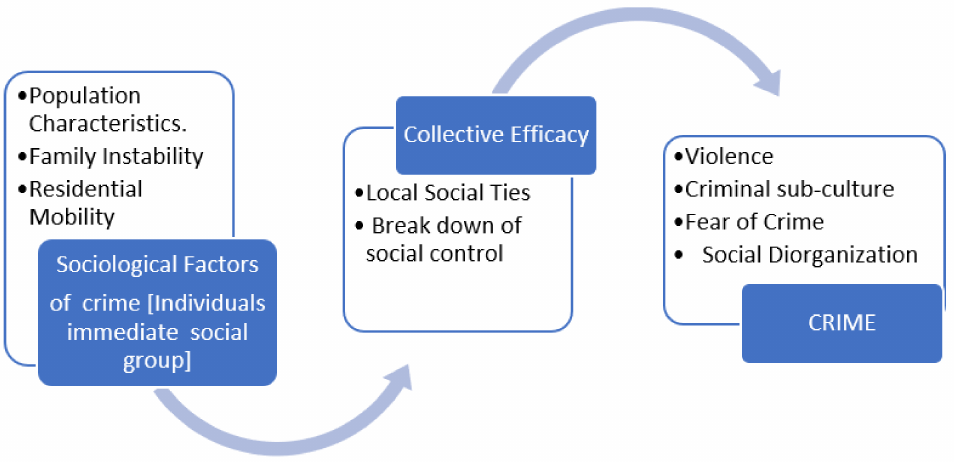
Figure 1. Social Disorganization